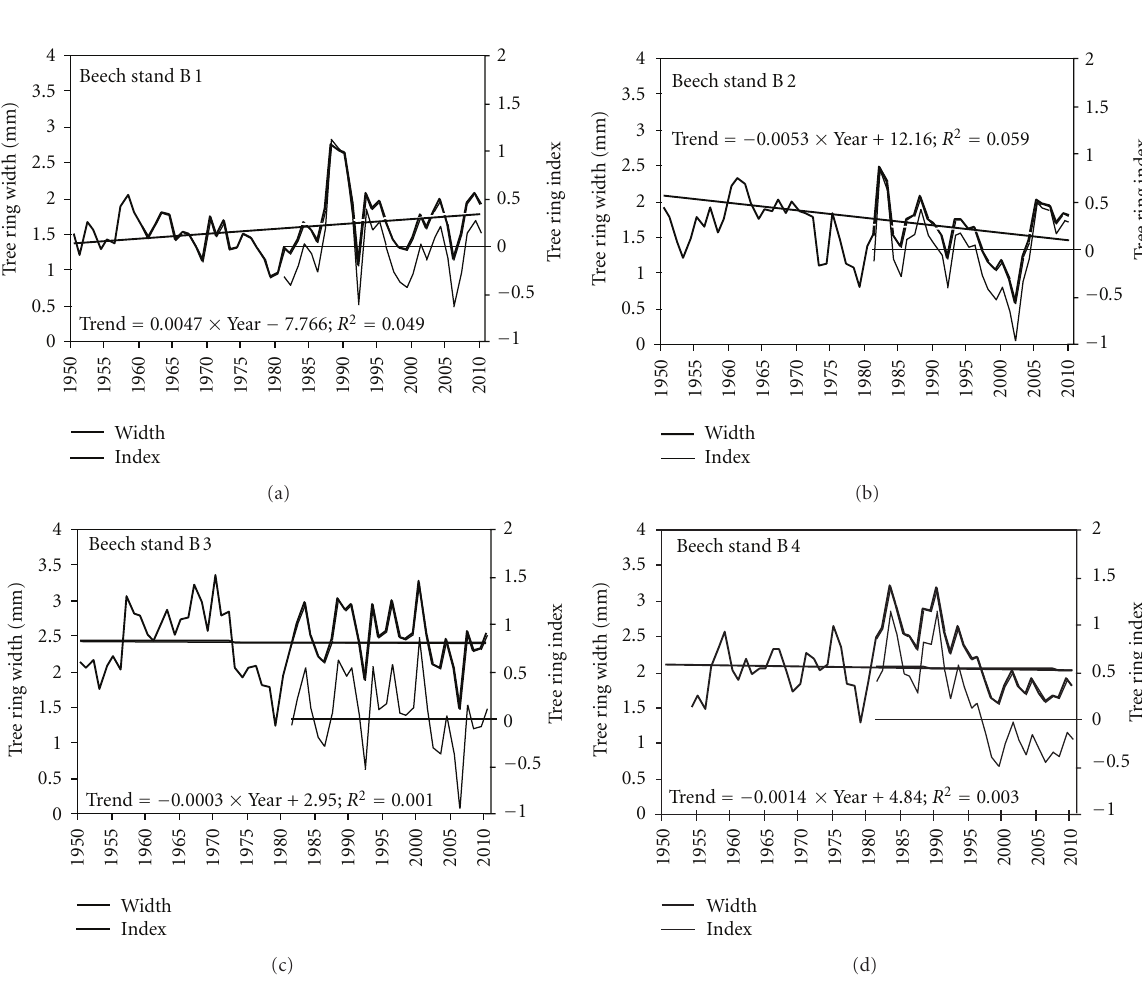
Figure 2: Mean tree ring with and their indices in monitored beech stands.